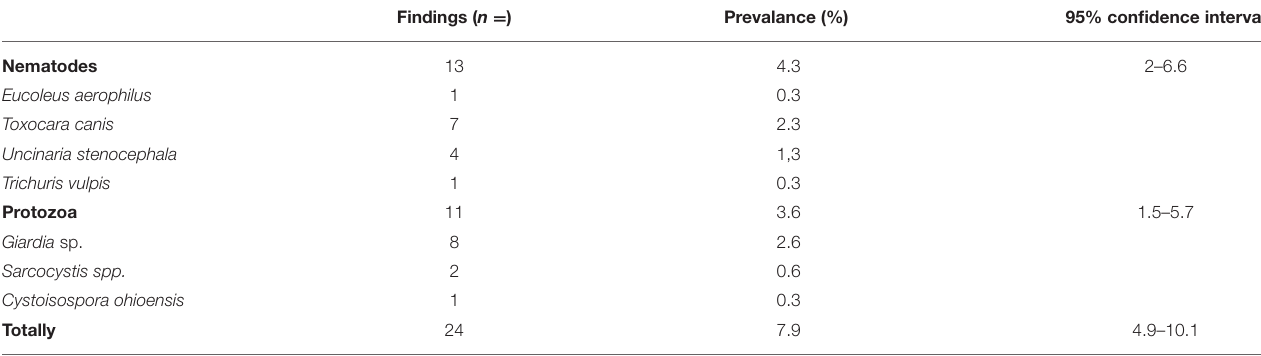
TABLE 2 | Occurrence of individual endoparasites.